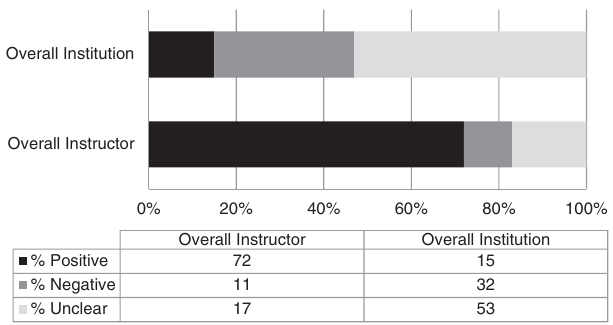
FIG. 1. Interviewees ’ overall attitudes of how well they and their institutions are able to assess teaching